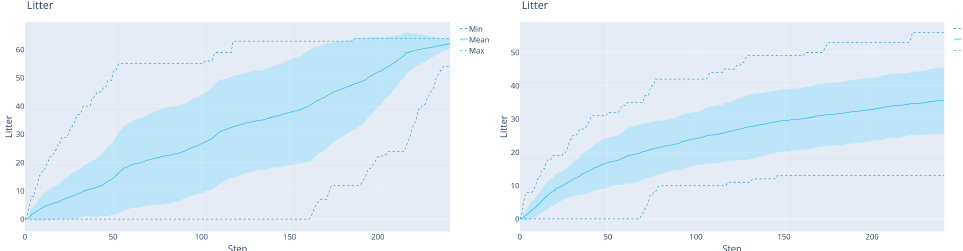
Figure 12. The results of the agents on the 40 validation maps, in the case with map size 27 × 27 × 24 maps. Left: LM agent. Right: DRL agent.